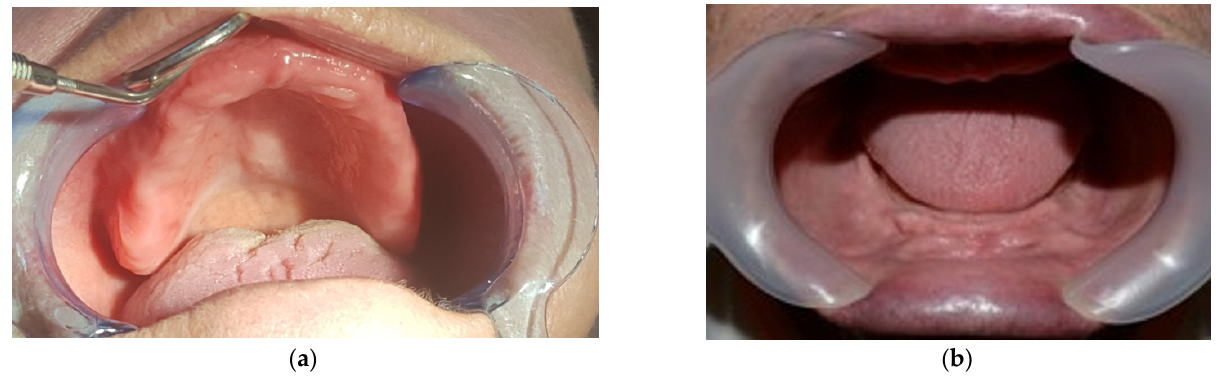
Figure 3. ( a ) Maxillary prosthetic field, with well-formed high ridges, voluminous tuberosities, slightly retentive vestibulo-distal, voluminous maxillary torus located posterior, flabby ridge apparently normal histological appearance at inspection, but with increased mobility; ( b ) lower prosthetic field with flabby ridge in the lower frontal area, atrophic, with hyperplasia of the vestibule groove by continuous trauma due to the edge of a lower prosthesis without maintenance and stability.